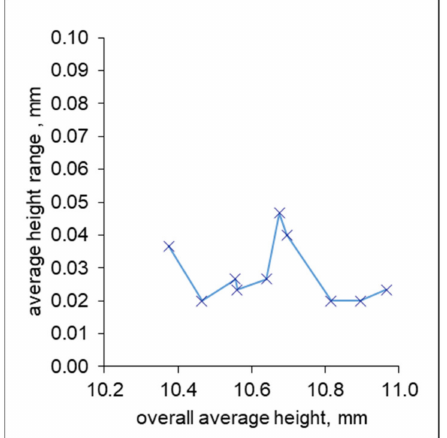
Figure 6. Dependence of the average range of repeated measurements on the height of